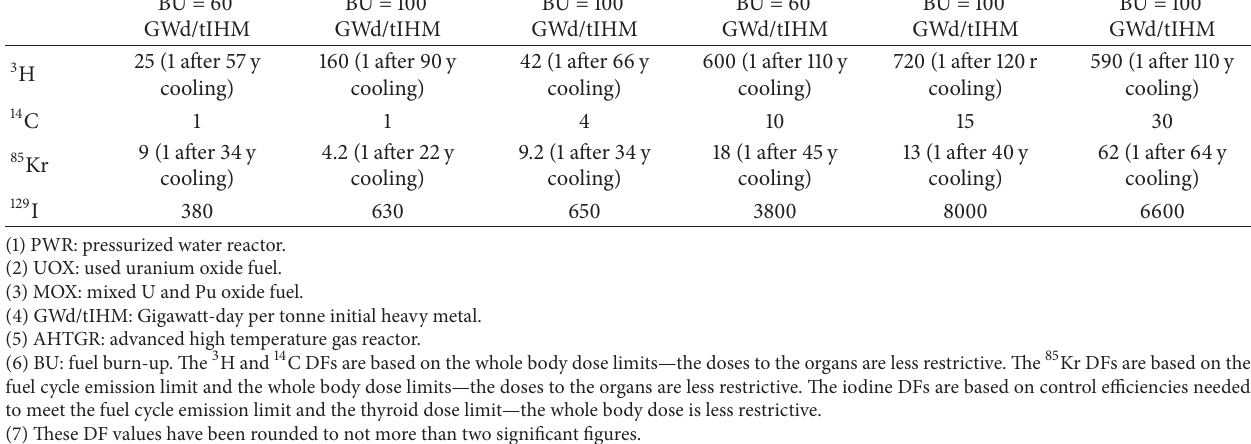
Table 2: Estimated DFs required for the volatile radionuclides for different selected types of used fuels and burn-ups. Assumed dose limit for the volatile radionuclides = 25mrem/y Nuclide and 75 mrem/y to thyroid (40 CFR